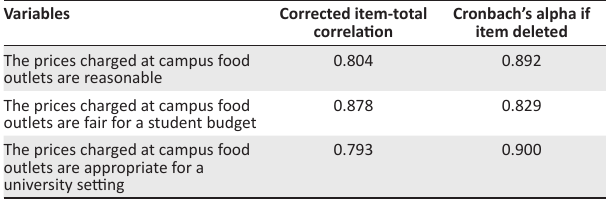
TABLE 2: Item-total statistics for the price perception